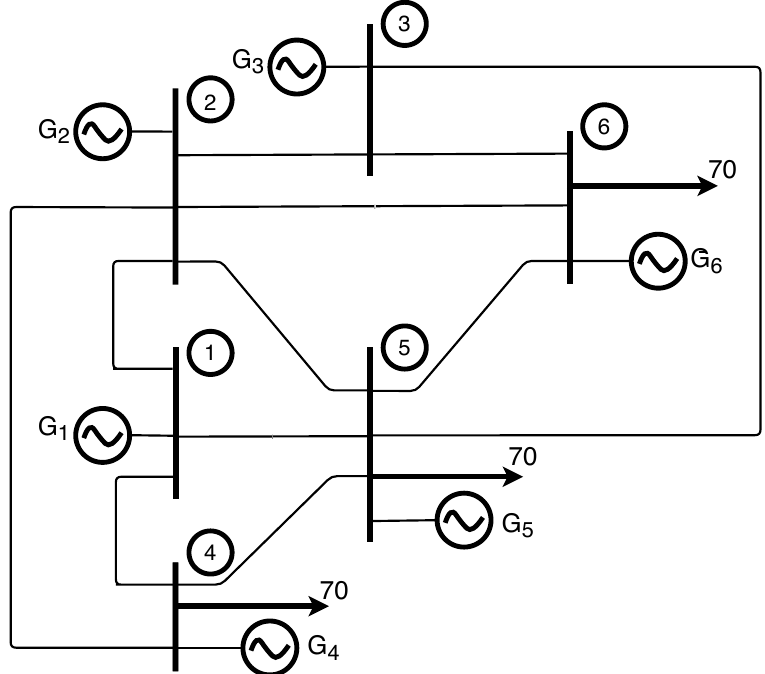
Figure 1. Test system I: A new 6-bus electrical power system is proposed in this study.